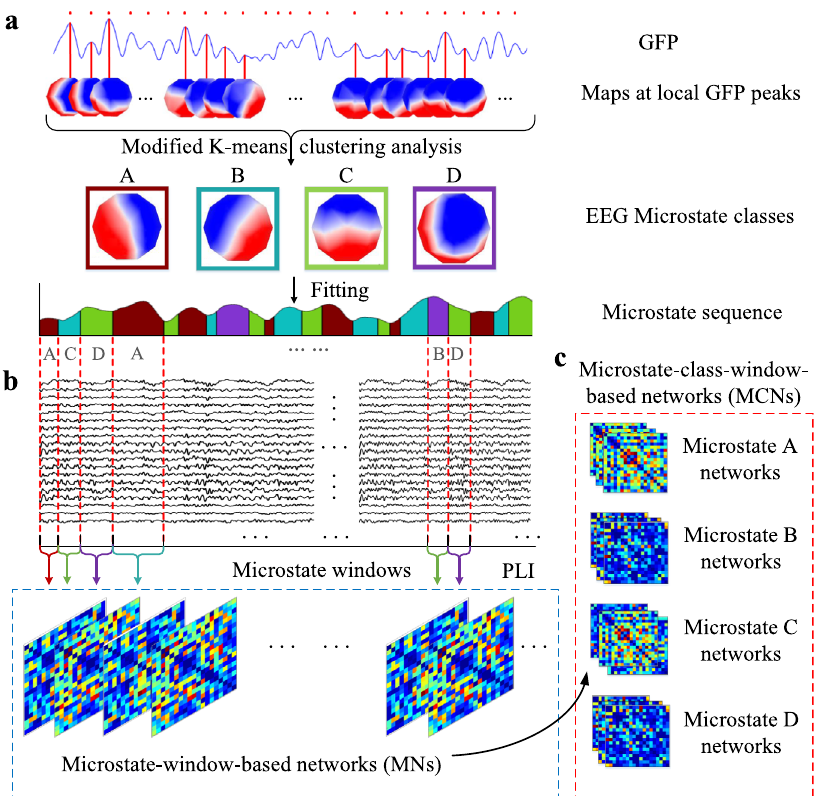
Fig. 7 Functional connectivity network construction based on EEG microstate analysis. a EEG microstate analysis is used to form the microstate sequence corresponding to EEG sequence. b The microstate windows are used to construct functional connectivity networks based on microstate sequences. c The functional connectivity networks based on microstate classes. GFP global fi eld power, SVM support vector machine, PLI phase lag